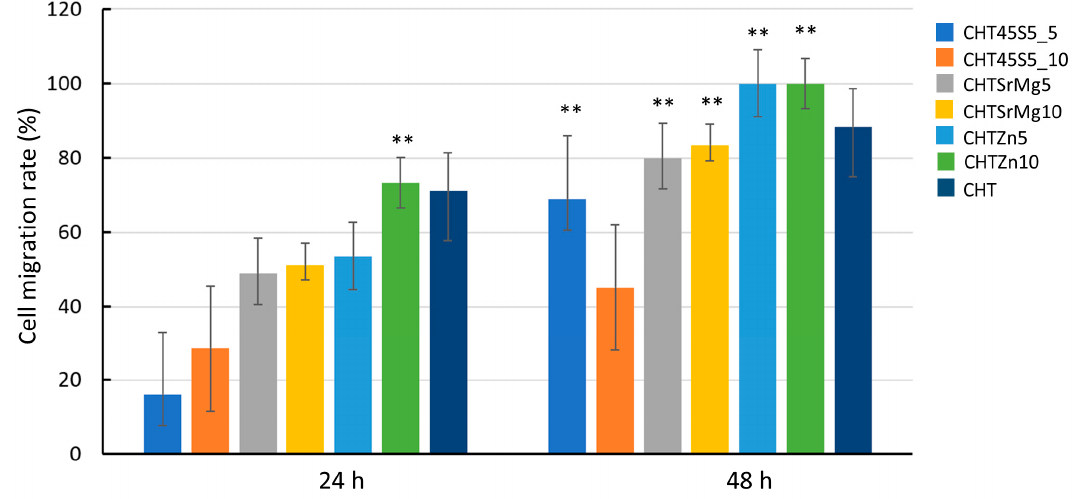
Figure 8. Cell migration rate (%) 24 and 48 h after the “scratch” on confluent monolayer of NIH 3T3 in contact with eluates of CHT, CHT45S5_5, CHT45S5_10, CHTSrMg5, CHTSrMg10, CHTZn5, and CHTZn10 wound dressings. ** p < 0.05.